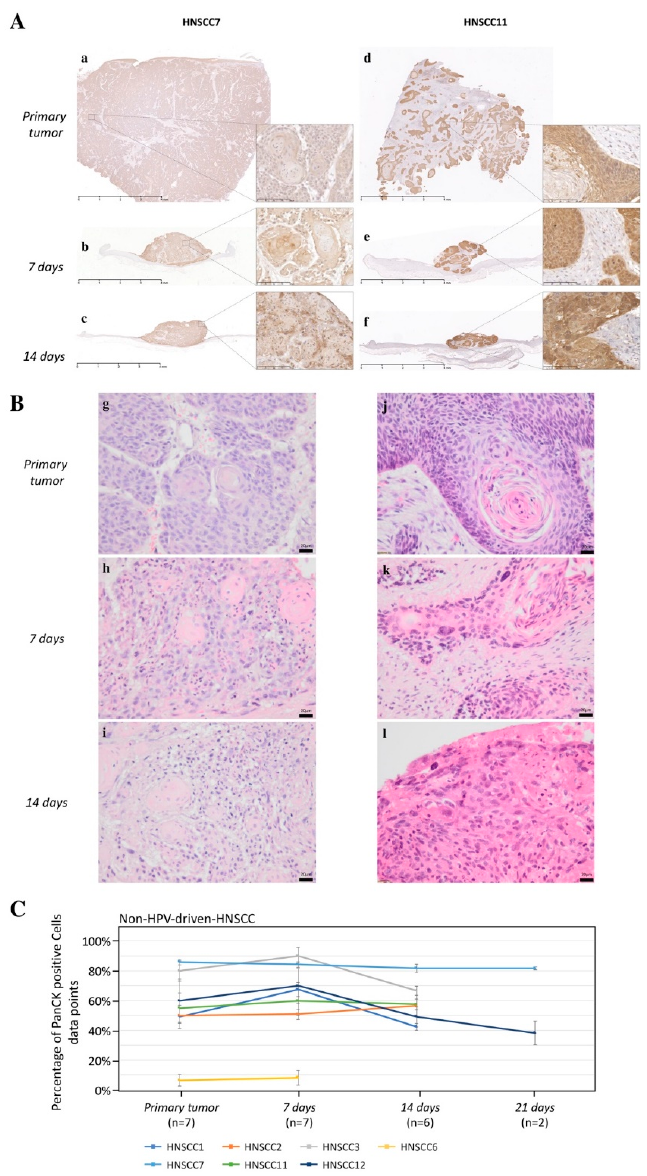
Figure 2. Morphology and PanCK-immunohistochemistry of two non-HPV-driven 3D-OTCs. An anti-PanCK antibody was used to visualize the amount and spatial distribution of PanCK-positive cancer cells (brown signal). For visualization of cellular integrity, details in 16-fold higher magnification are shown for each sample ( A ). Scale Bar in images with lower magnification: 4 mm, and higher magnisfication: 100 µ m. ( B ) H / E staining of the according samples. Scale bar: 20 µ m. ( C ) Mean values of tumor cell proportion of all primaries and 3D-OTCs on day 7, 14, and 21 of all non-HPV-driven HNSCC. Error bars indicate standard errors of the mean. Abbreviations: PanCK, pan-cytokeratin; HPV, human papillomavirus; 3D-OTC, 3D organotypic co-culture; H / E, hematoxylin and eosin. HNSCC, head and neck squamous cell